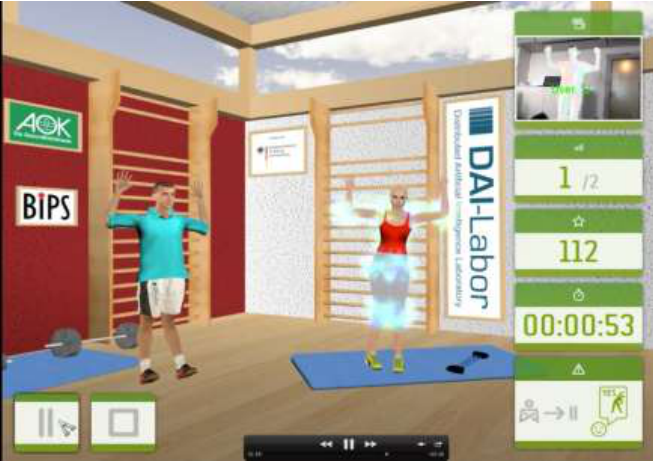
Figure 3. User interface of the Activity Assistant.